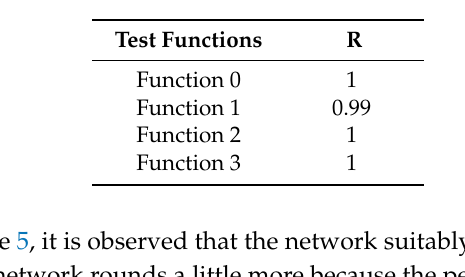
Table 2. Maximum points of the test functions.